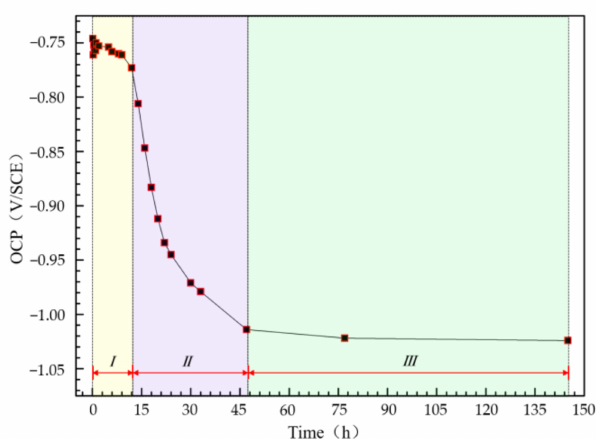
Figure 6. Change of OCP of the Al–BN ACS with immersion time in 5.0 wt % NaCl